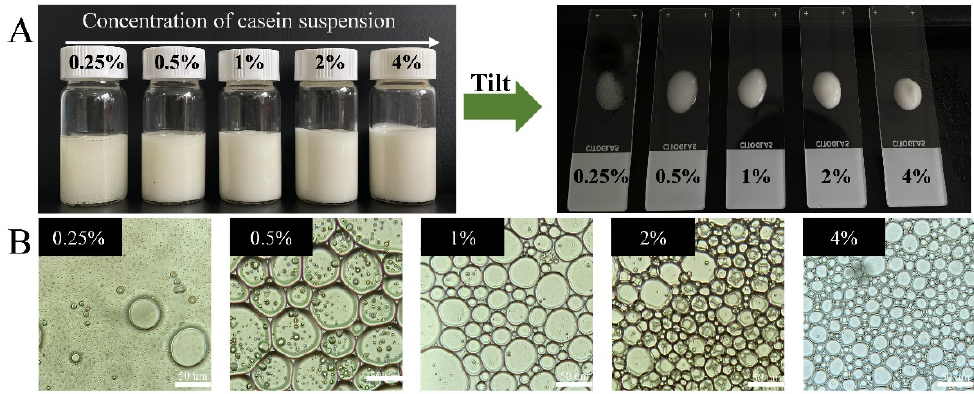
Figure 1. Appearance ( A ) and optical micrographs ( B ) of high internal phase emulsions (HIPEs) ( φ = 0.75) of soybean oil under different casein concentrations in the continuous (water) phase (0.25, 0.5, 1, 2, and 4%, w/w ). Scale bars, 50 µm.